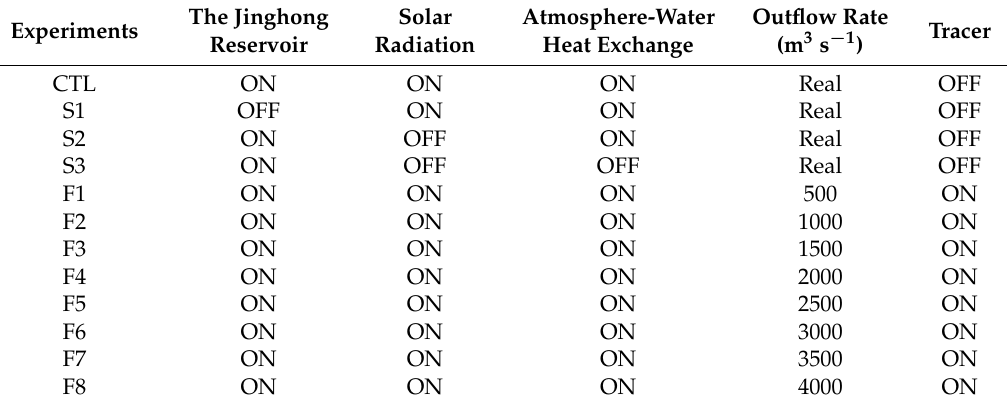
Table 2. An overview of numerical